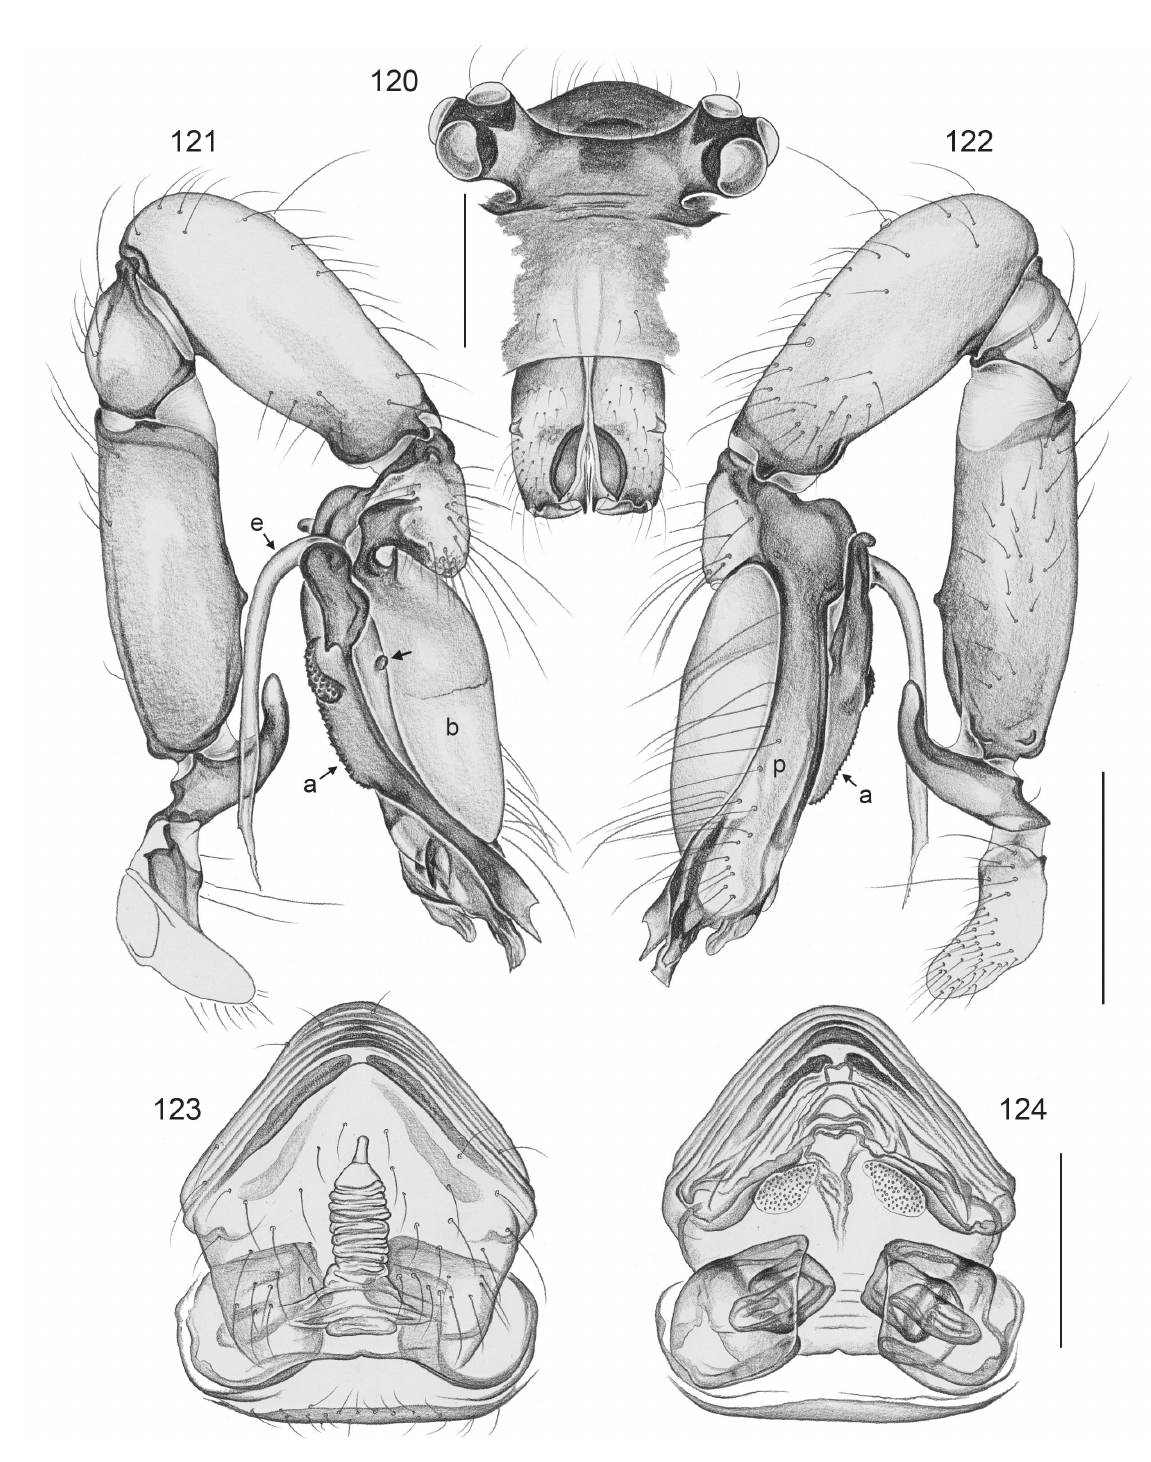
Figs 120–124. Pholcus bario Huber sp. nov. (ZFMK, Ar 15717–18). 120 . Male prosoma, frontal view. 121–122 . Left male palp, prolateral and retrolateral views; arrow points at prolateral finger-shaped process of procursus. 123–124 . Cleared female genitalia, ventral and dorsal views. Scale bars: 120, 123–124 = 0.3 mm; 121–122 = 0.5